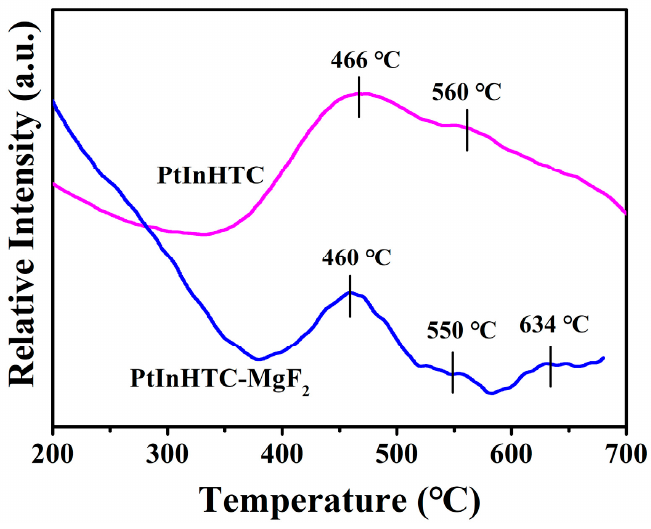
Figure 4. H 2 -TPR profiles of the catalysts.